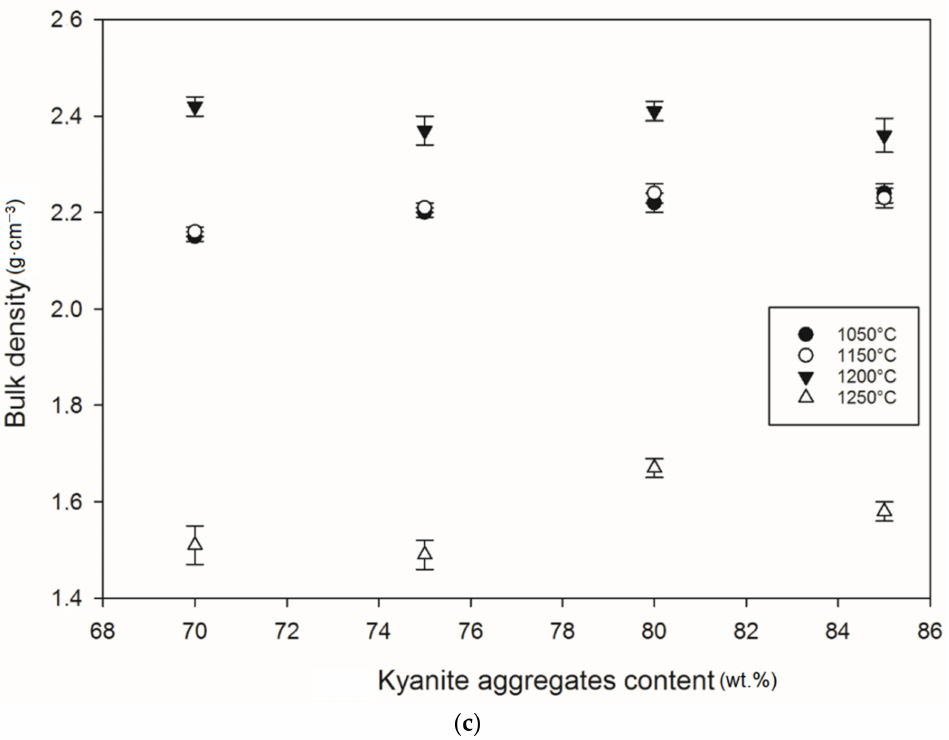
Figure 12. Bulk density behavior: ( a ) RB series, ( b ) RC series and ( c ) RD series.